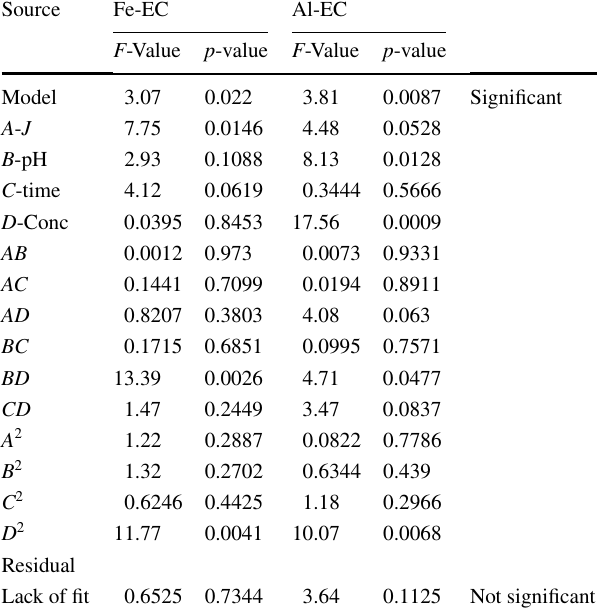
Table 3 ANOVA and regression results for the response surface quadratic model for fluoride reduction by Fe-EC and Al-EC reactors